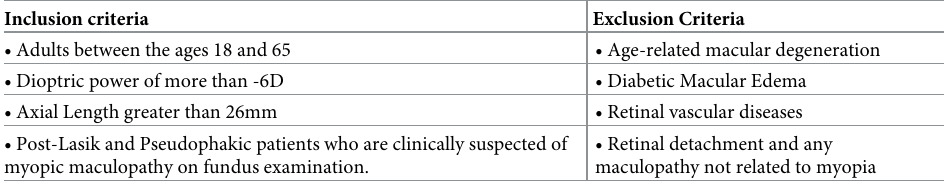
Table 1. Inclusion and exclusion criteria for the mCNV